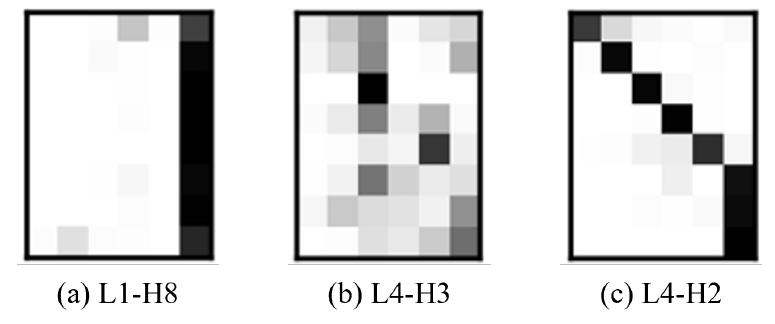
Figure 4. Examples of cross-attention